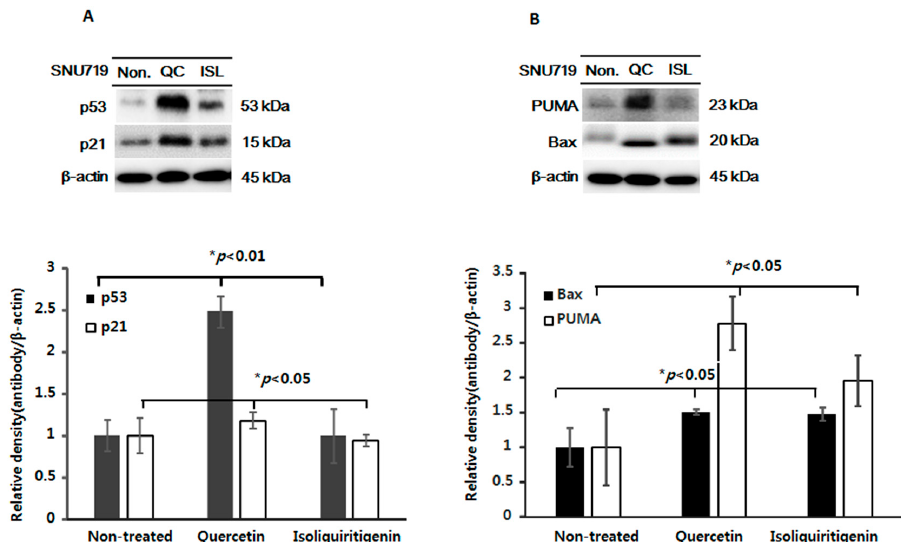
Figure 3. Expression of p53, p21, PUMA, and Bax in tumor tissues from mice implanted with EBV(+) human gastric carcinoma (SNU719) EBV(+) human gastric carcinoma tumor tissue was excised